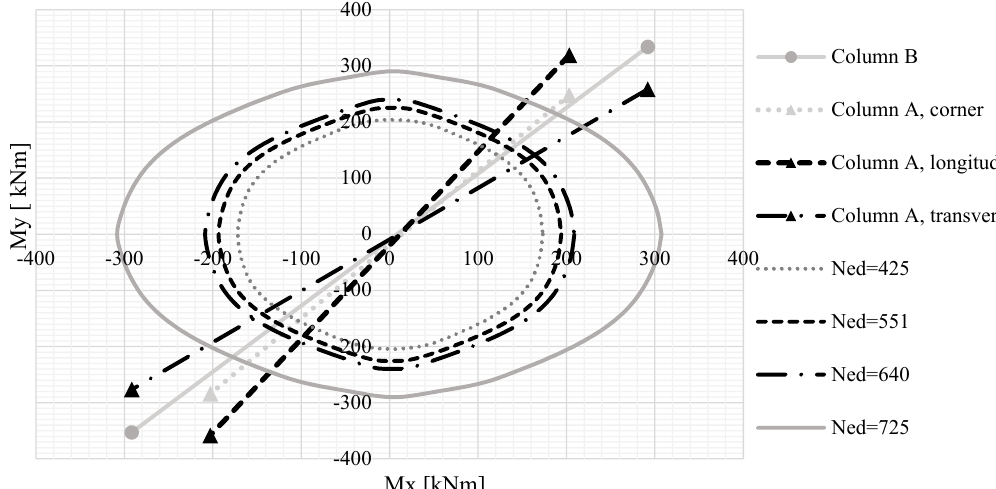
Figure 9. Resistance domains for columns of the static scheme with hinges.